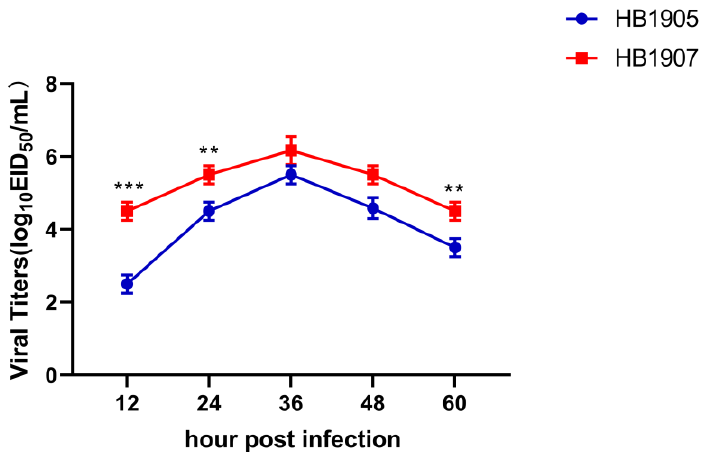
Figure 4. Virus titers at different time points in MDCK cells. The two strains (HB1905 and HB1907) infected cells with an MOI of 0.01 (10 5 cells). At 12, 24, 36, 48 and 60 hpi, cell supernatants were collected and inoculated into SPF chicken embryos. The titer of the virus at different time points was determined by EID 50 . Three independent experiments were performed in each group (** p < 0.01, *** p < 0.001).